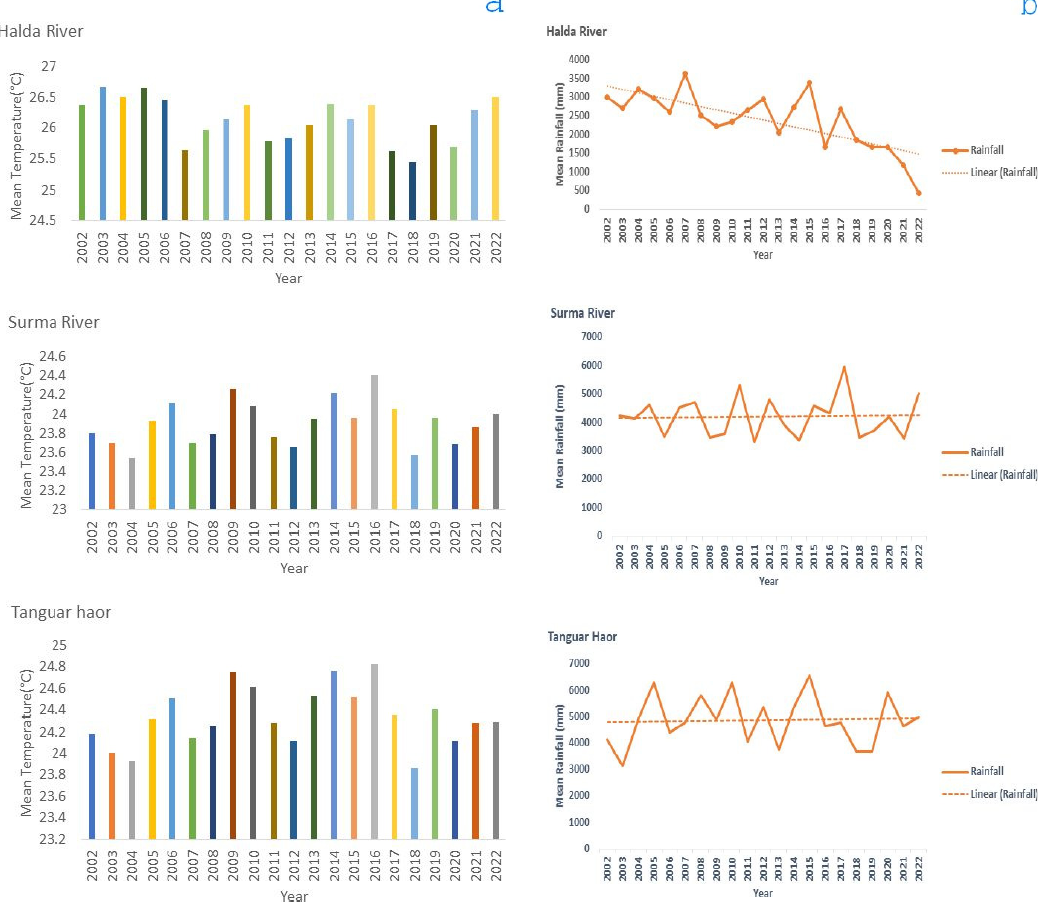
Figure 4. Graphical representation of the yearly mean temperature ( a ) and rainfall ( b ) value of the last 20 years of the study area.